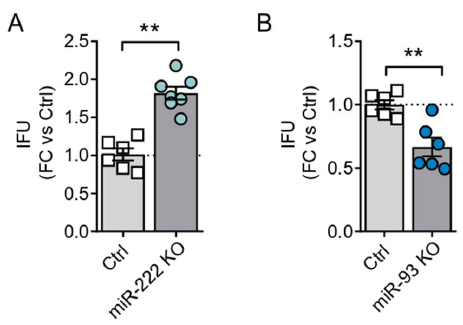
Figure 2. Viral particles release in miR-222 KO and miR-93 KO cells. PANC-1 Ctrl and KO